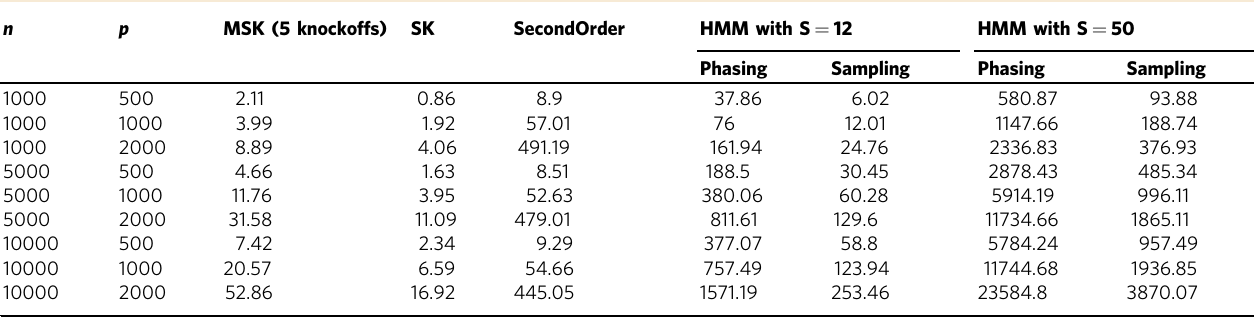
Table 1 Computing time of different knockoff